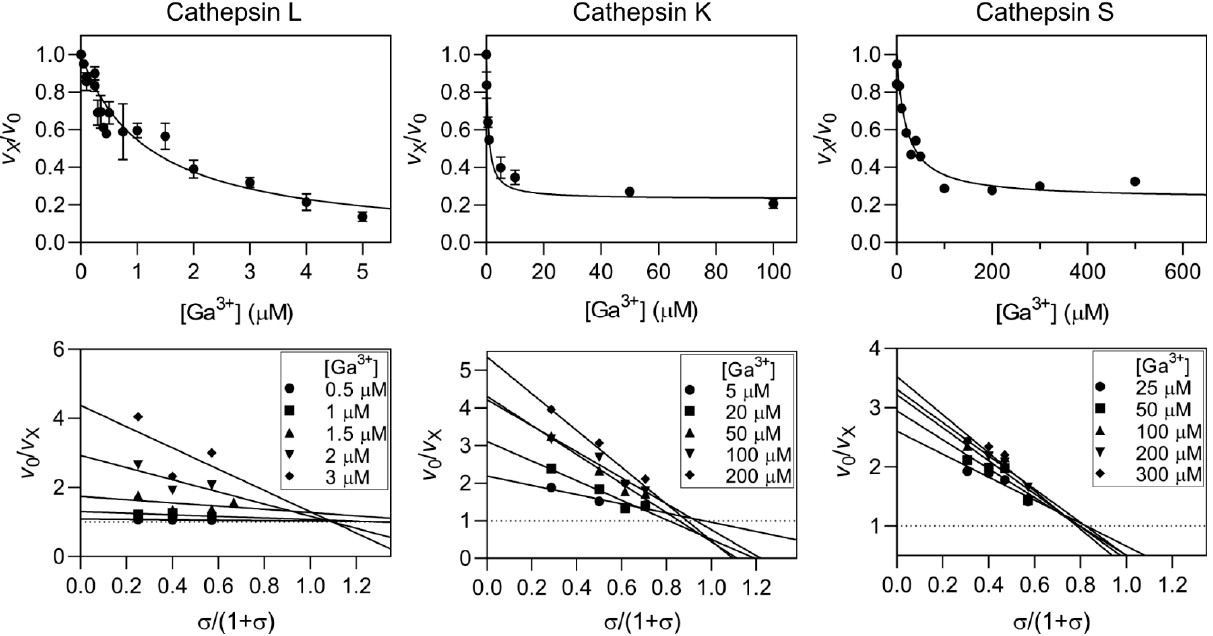
Figure 3. Inhibition of cathepsins L, K, and S by Ga 3+ ions. The titration curves are shown in the upper panels and the specific velocity plots used to determine the inhibition mechanisms are shown in the lower panels. Activity was measured with synthetic fluorogenic substrates (Z-Leu-Arg-AMC, Z-Phe-Arg-AMC and Z-Val-Val-Arg-AMC for cathepsins L, K, and S, respectively) at 25 °C in 0.1 M sodium acetate buffer pH 5.5. σ is equal to [S]/ K m . The error bars in the titration curves represent the S.E.M. of multiple independent experiments.